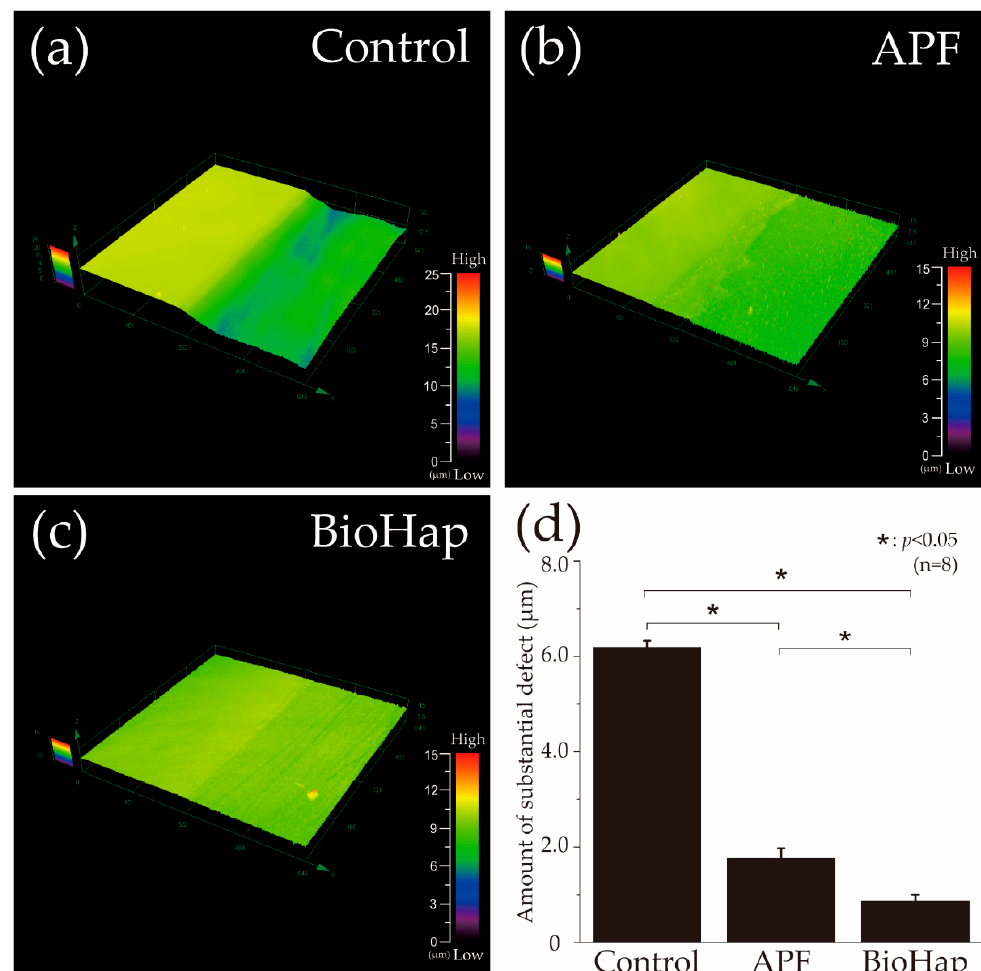
Figure 2. Height difference profiles measured using 3D laser microscope. ( a ) Boundary images of reference and experimental surfaces after acid challenge in the control (not fluoride-treated), ( b ) acidulated phosphate fluoride (APF, 9048 ppmF, pH 3.6), and ( c ) BioHap with APF (9048 ppmF, pH 3.6) groups. The left side in a–c shows the reference surface protected by wax and not demineralized; the right side shows the demineralized experimental surface. ( d ) Graphical representation of substantial defects due to demineralization (n = 8, *: p < 0.05).